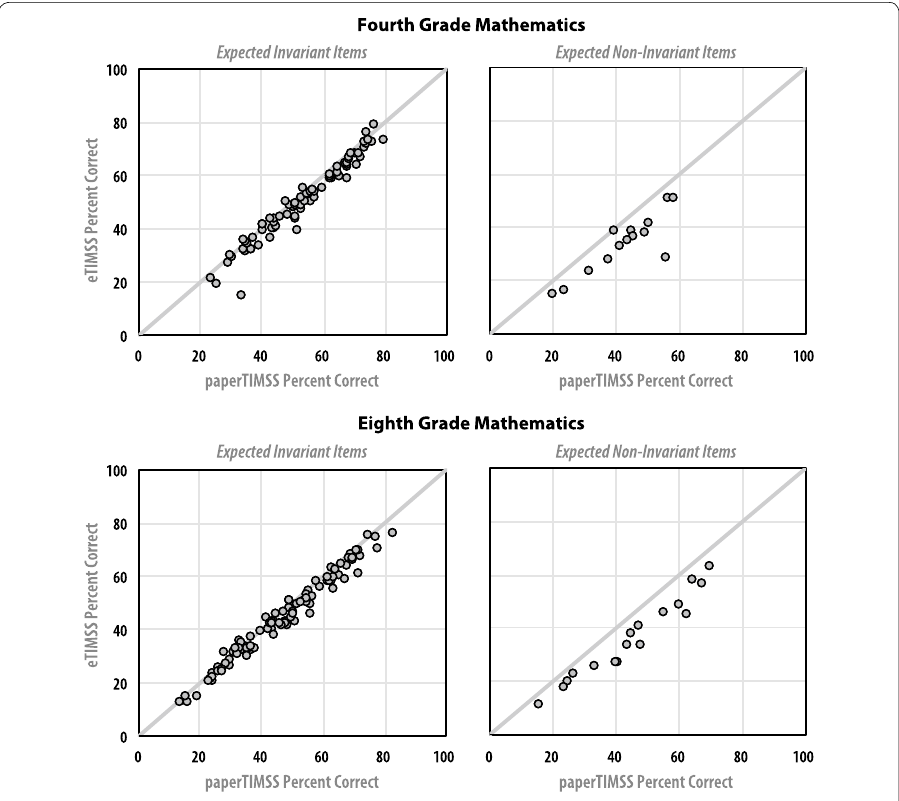
Fig. 1 Item plots of international average percent correct statistics for mathematics—paperTIMSS vs. eTIMSS. Each data point represents a mathematics trend item with x -axis the percent correct based on paperTIMSS data and y -axis percent correct based on eTIMSS data. Expected invariant items (left) were included in the analysis. Expected non - invariant items (right) were plotted as a means of